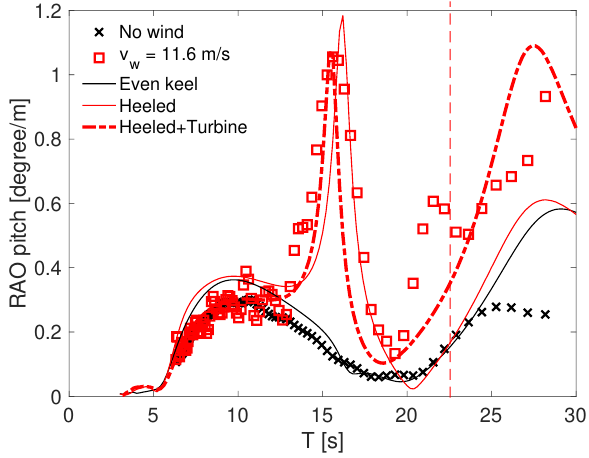
Figure 18. Final numerical model calibration versus experimental data (without TA). The dashed lines represent the experimental natural periods from Table